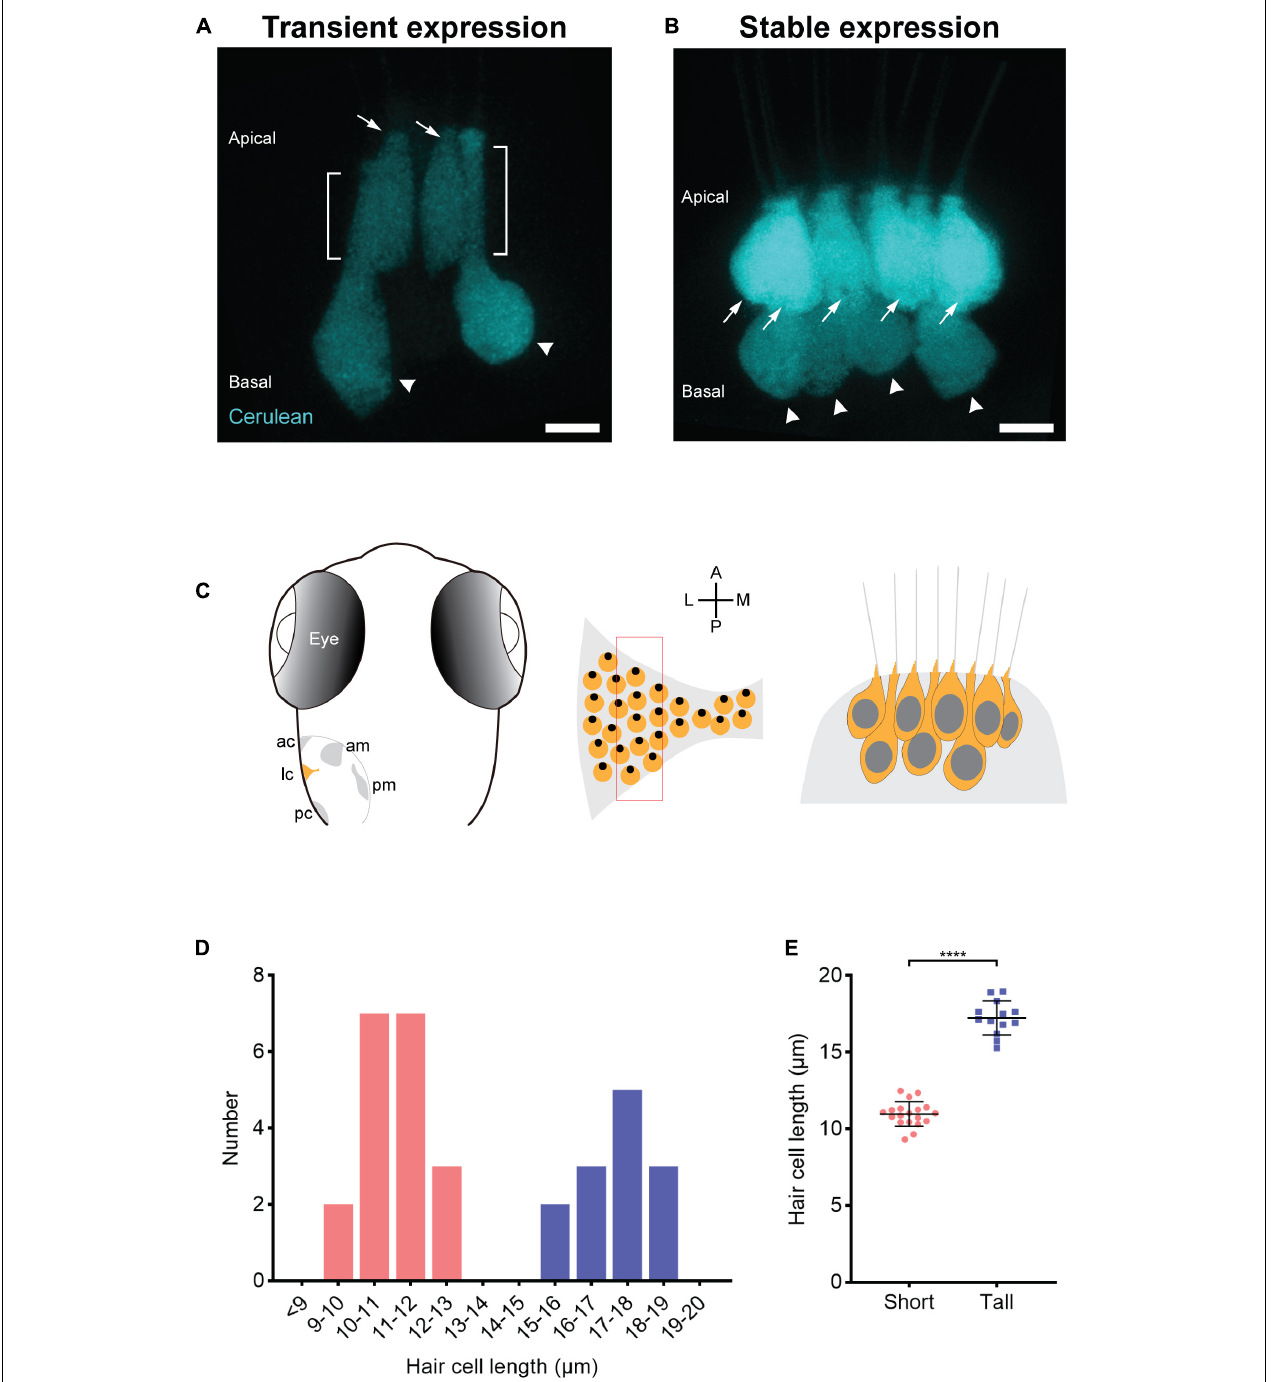
FIGURE 1 | Two populations of morphologically distinct hair cells in the central thickness of the lateral crista of larval zebrafish. (A,B) Transient (A) and stable (B) transgenic expression of Cerulean fluorescent protein in the lateral crista reveals two morphologically distinct hair cells: short (arrows) and tall (arrowheads). The brackets mark the neck regions of tall hair cells. Scale bar = 5 µ m. (C) Left panel, schematic of a dorsal view of a 7-dpf zebrafish ear, illustrating the five mechanosensory patches: the anterior crista (ac), lateral crista (lc), posterior crista (pc), anterior macula (am), and posterior macula (pm). Middle panel, enlarged view schematizing the hair cell arrangement in the lateral crista highlighted in yellow in the left panel. Each yellow circle represents a single hair cell, and the black dot within represents the position of the kinocilium (fonticulus). The red rectangle marks the section from which the hair cells are imaged and characterized. A, anterior; P, posterior; M, medial; L, lateral. Right panel, schematic of the two populations of hair cells (short and tall) in this section of the lateral crista based on imaging results. (D) The distribution of somata lengths of the lateral crista hair cells from 7-dpf zebrafish. n = 4. Pink bars represent short hair cells. Blue bars represent tall hair cells. (E) The somata lengths (mean ± SD) of the two groups of hair cells shown in panel (D) . **** P < 0.0001, unpaired t -test.